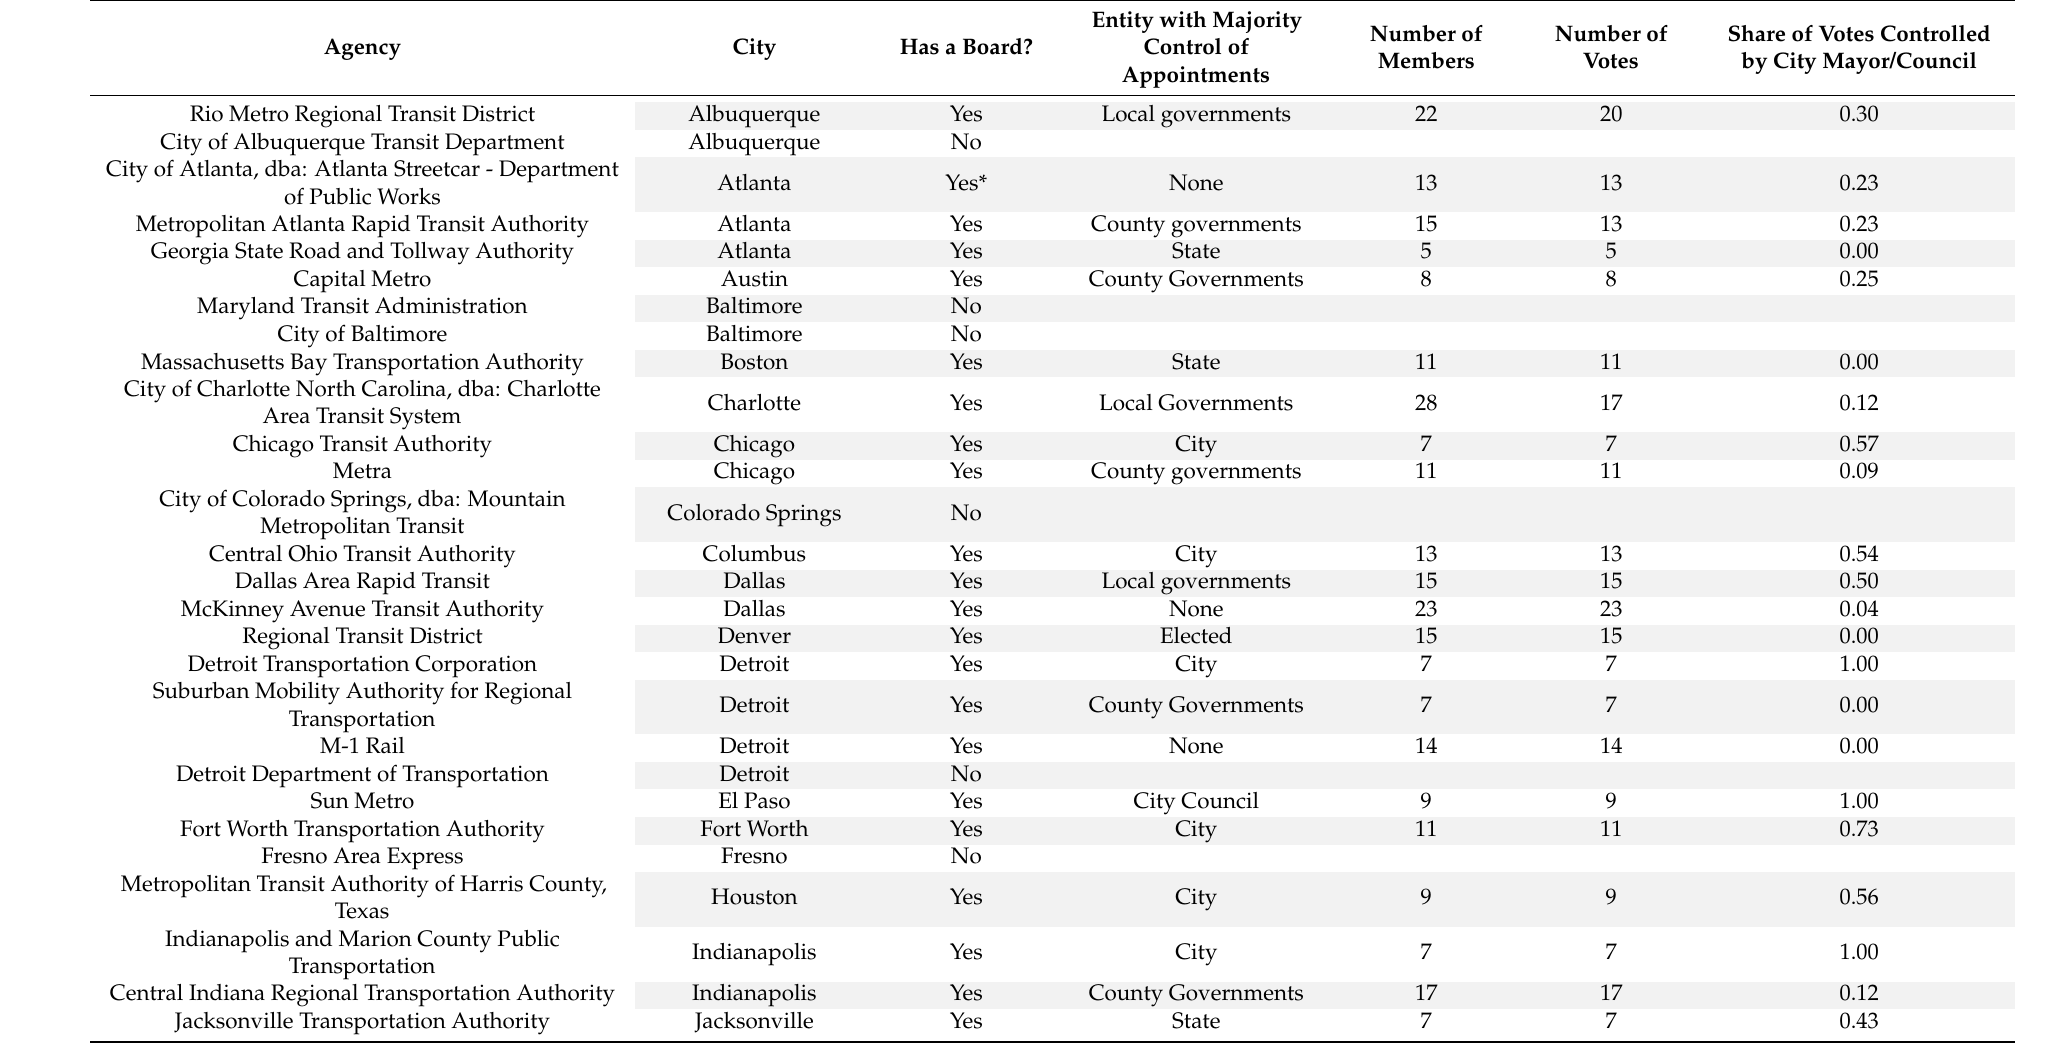
Table 1. Agency Board Composition and